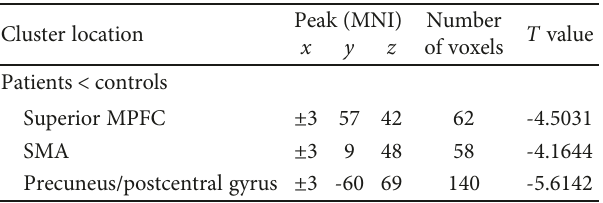
Table 2: Signi fi cant group di ff erences in VMHC. Cluster location